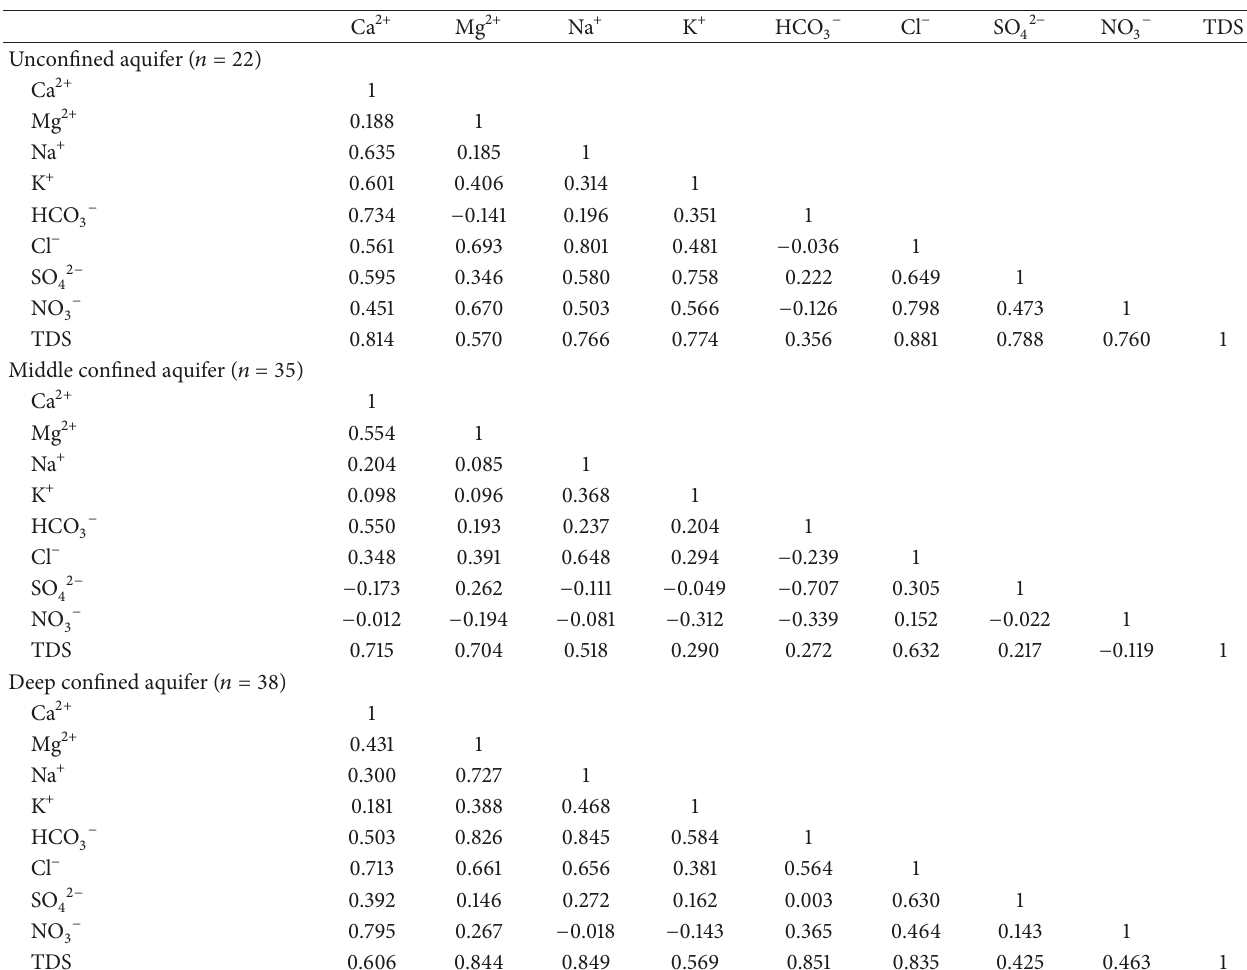
Table 4: Correlation matrix between TDS and the major